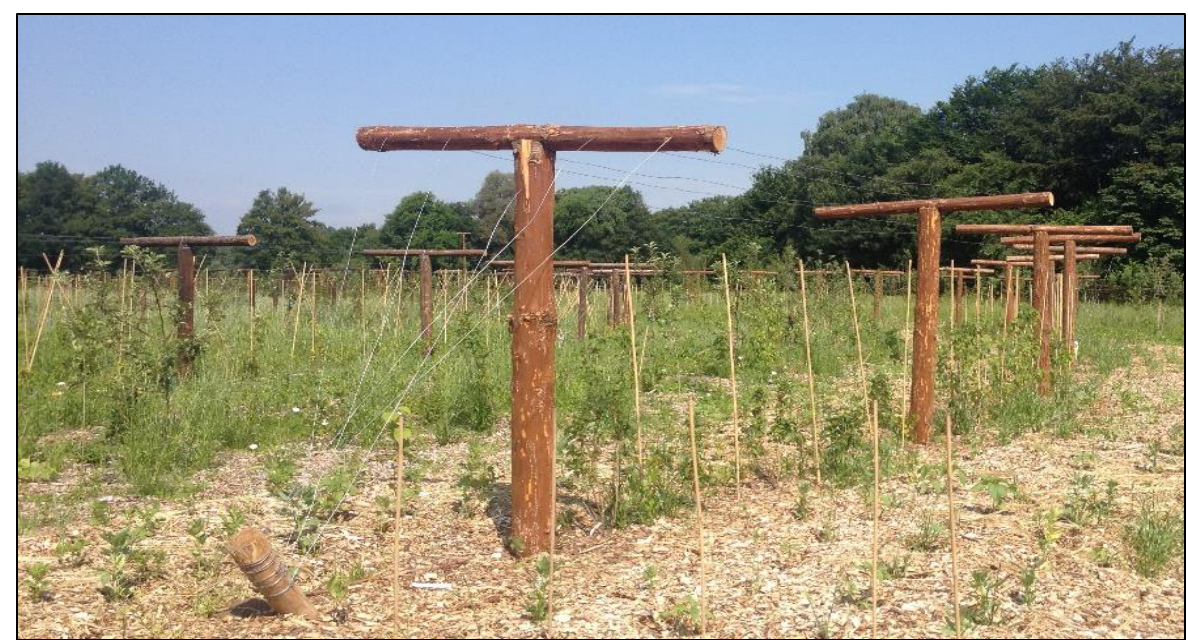
Figure 1. The Trellis at Den Food Bosch Runs in a Semicircle Suncatch